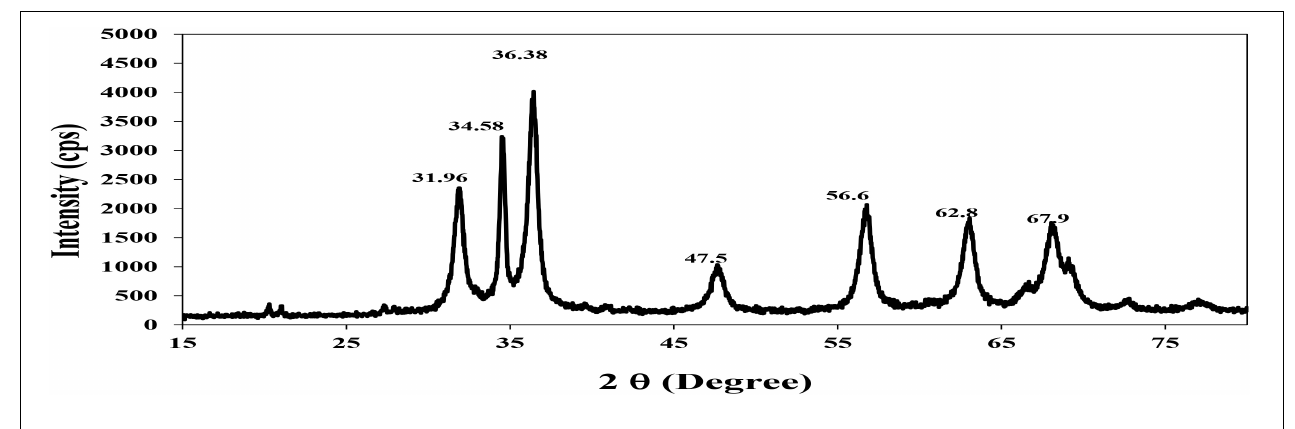
FIGURE 4 | XRD pattern of zinc